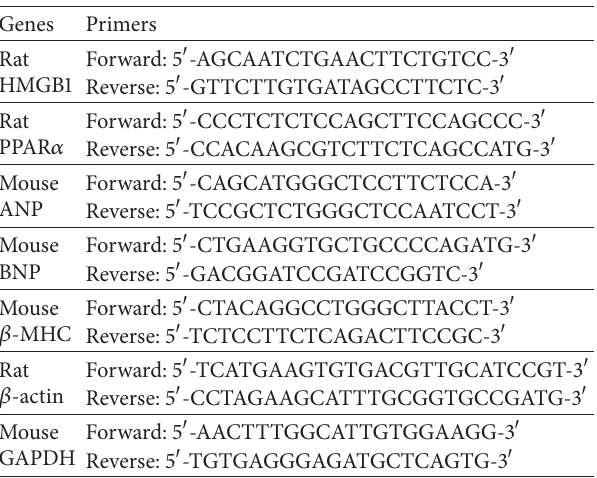
Table 1: Primers for real-time